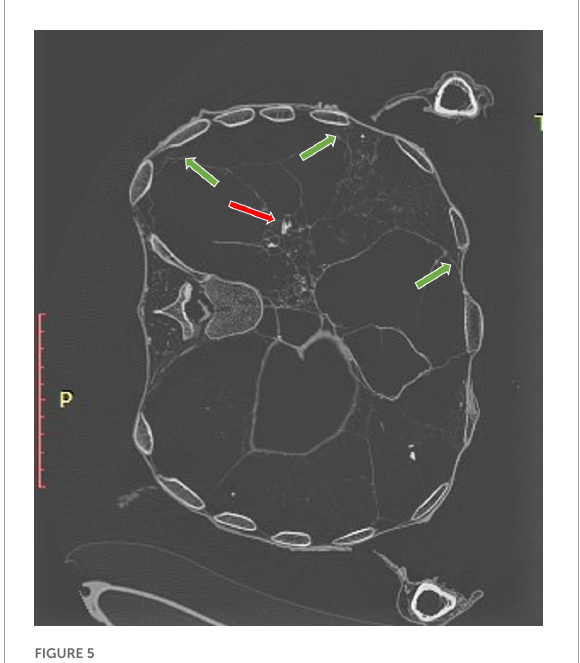
FIGURE5 CT scan of the thorax: the lung parenchyma is focally condensed and shows multiple small calcifications (red arrow). Furthermore, both lungs appear as widely attached to the thorax wall (green arrows) suggesting post-inflammatory pleuritic adhesions.